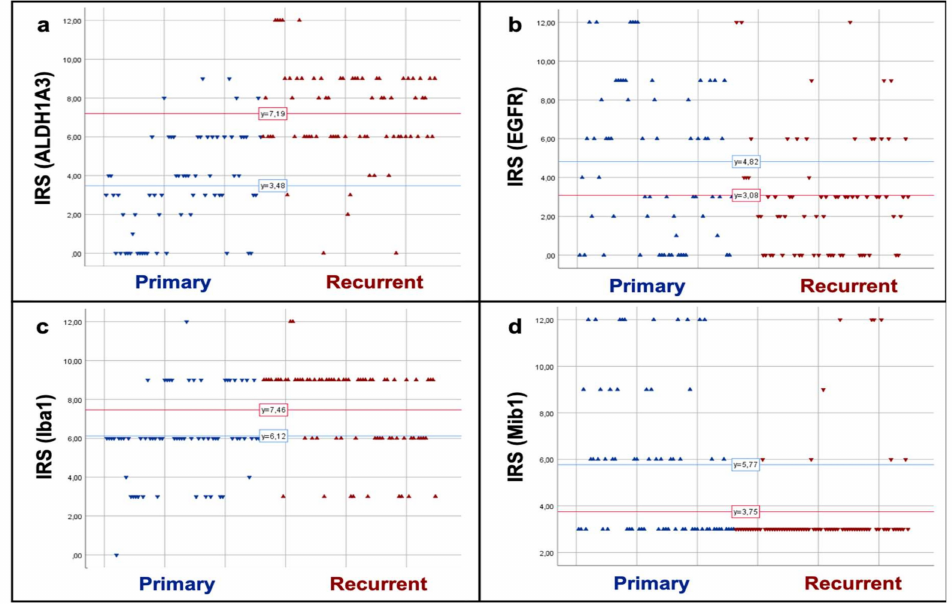
Figure 6. Comparison of marker expression in primary and recurrent GBM. The charts show a strong increase of ALDH1A3 ( a ) and Iba1 ( c ) positivity between primary and recurrent tumors. In contrast, EGFR ( b ) and proliferation (Mib1; d )